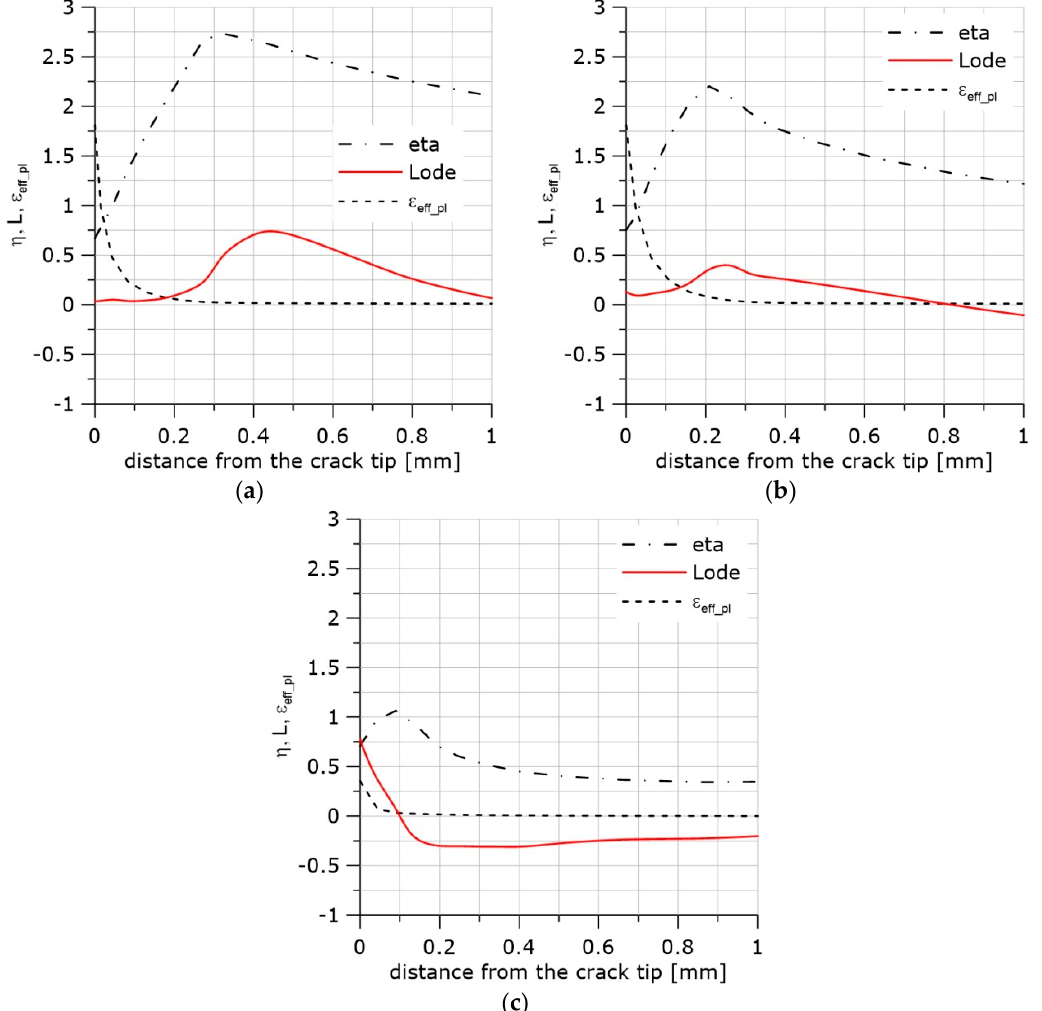
Figure 2. Distributions of η , L , and ε eff_pl in front of the crack. Material S355JR (heat treatment NW, Table 1). ( a ) The central part of the specimen; ( b ) the layer located 1.75 mm from the surface; ( c ) the next to last layer from the specimen axis.